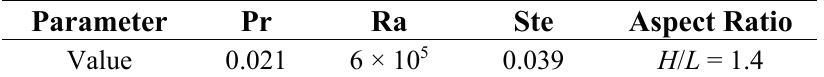
Table 2. The melting benchmark parameters of pure Gallium [30,31].